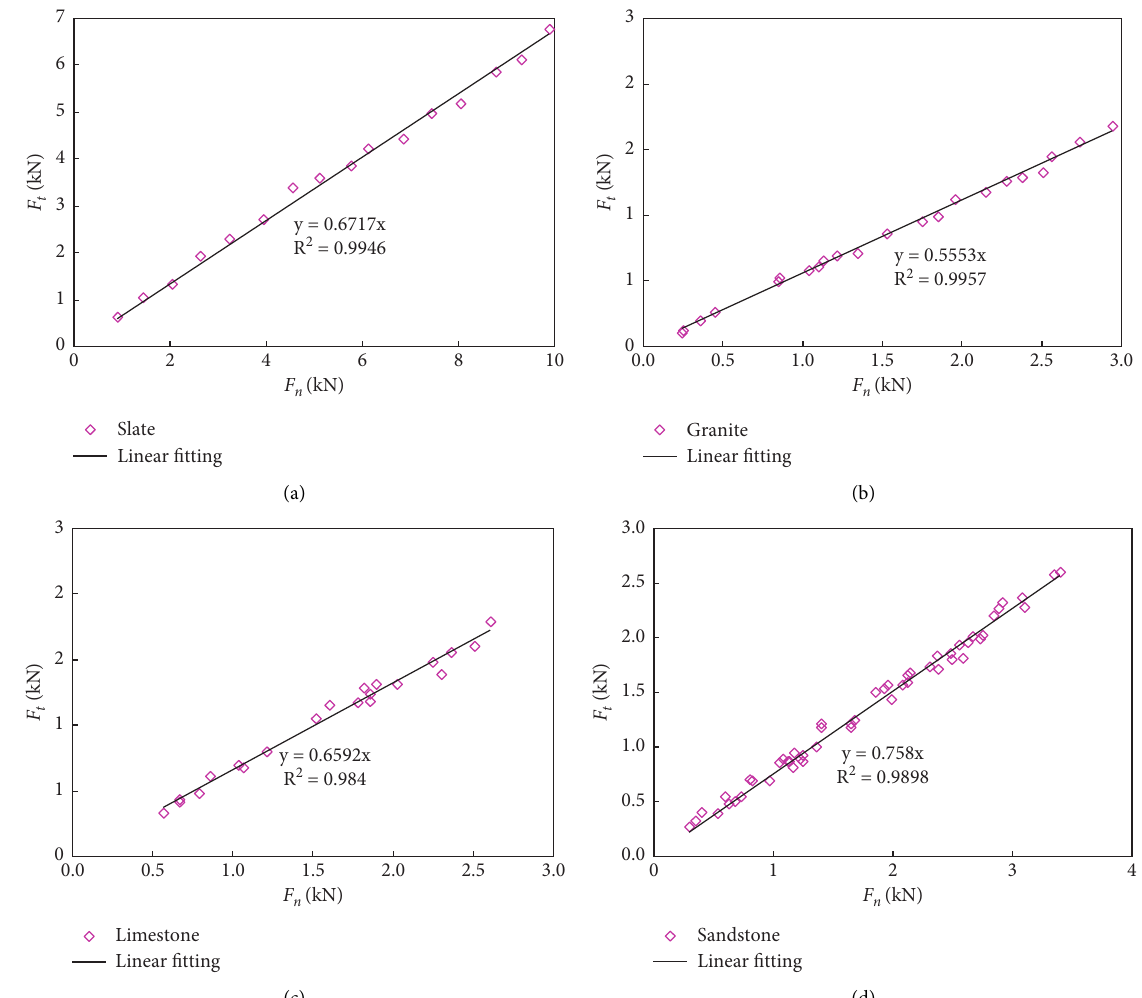
Figure 6: The thrust force-torque force curves of slate, granite, red sandstone, and